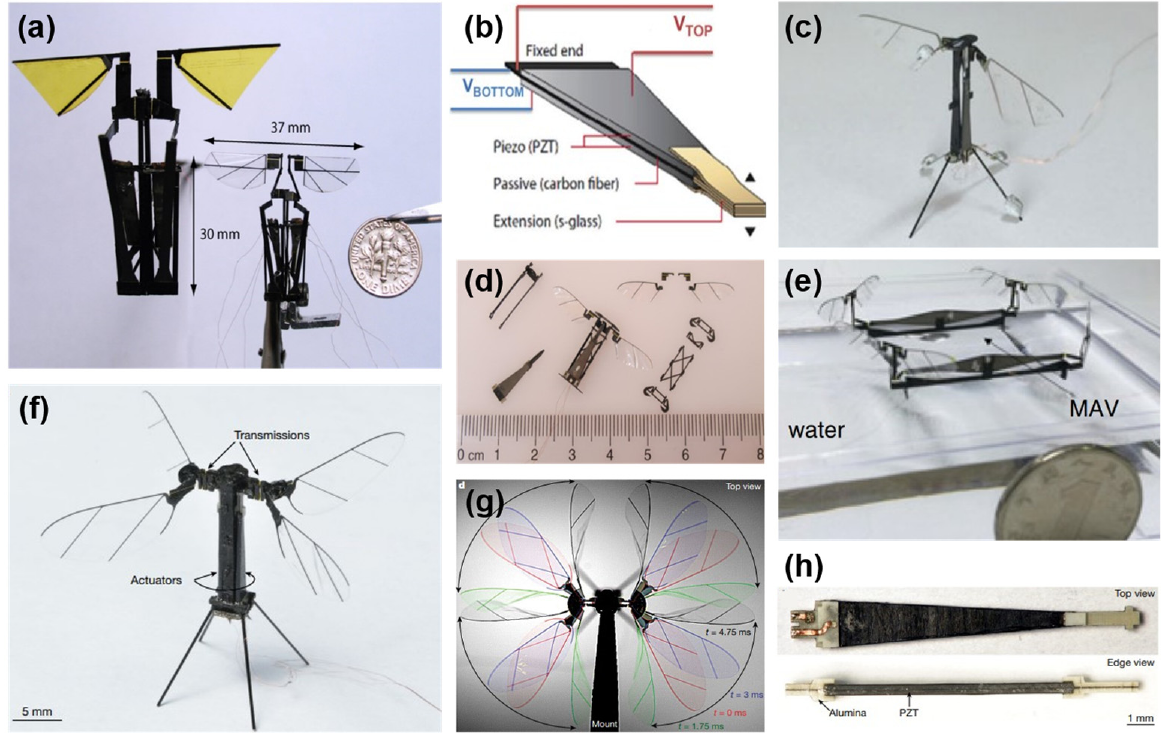
Figure 4. ( a ) Large and small flapping-wing prototypes. Reprinted with permission from Ref. [33].